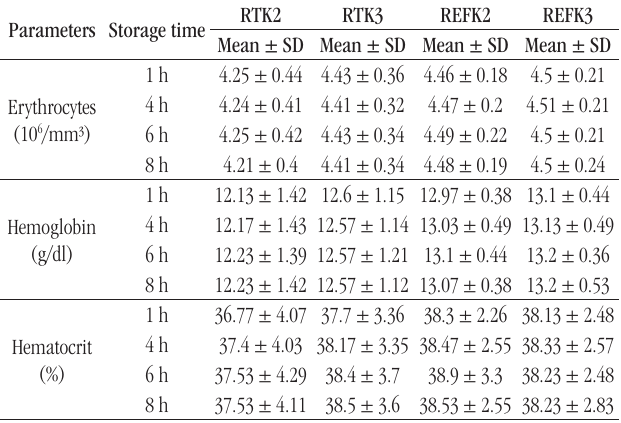
table 2 – Mean profile of leukocyte count parameters, according to temperature and storage